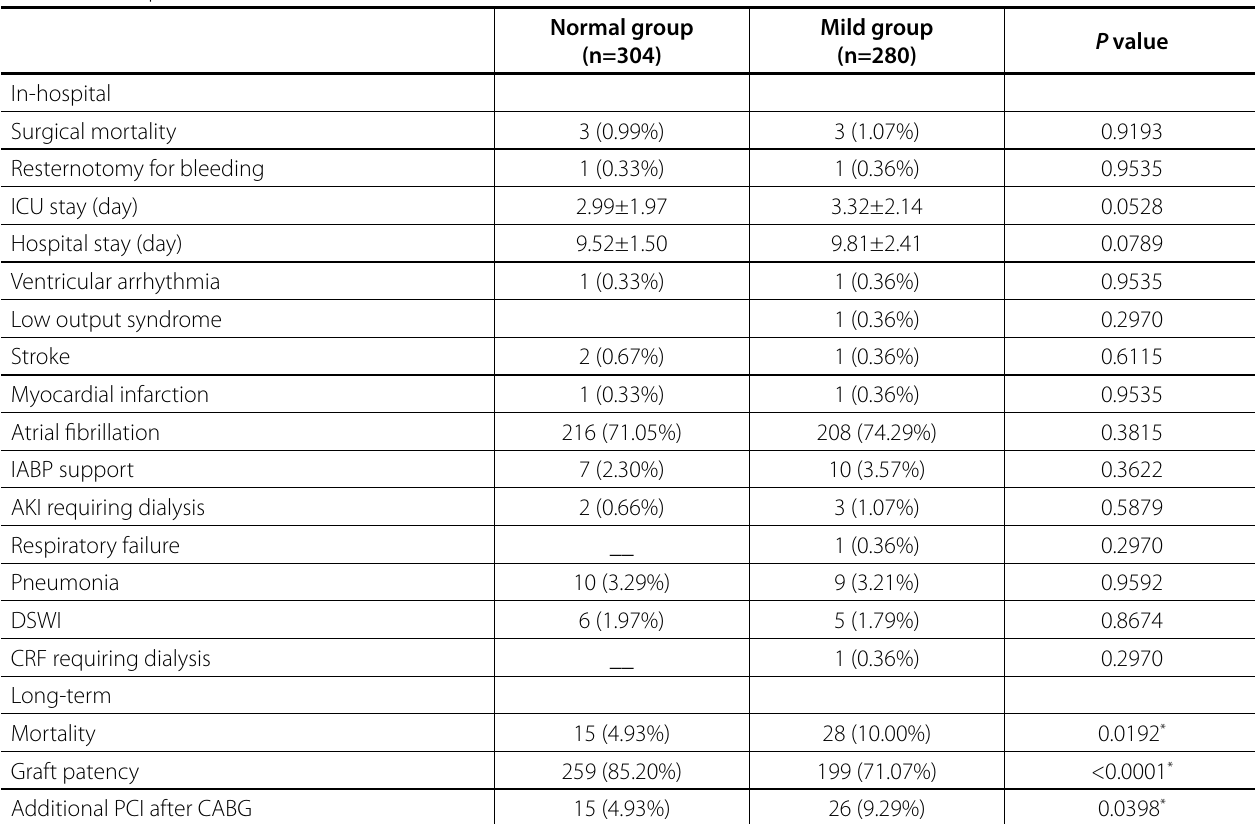
Table 3 . Postoperative